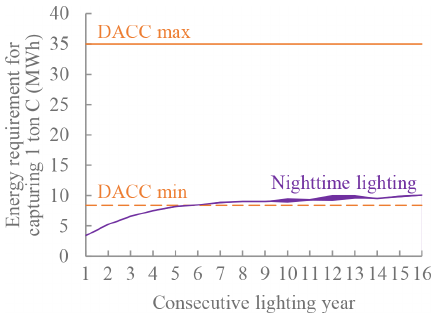
Figure 5. Energy requirement for DACC and the nighttime lighting